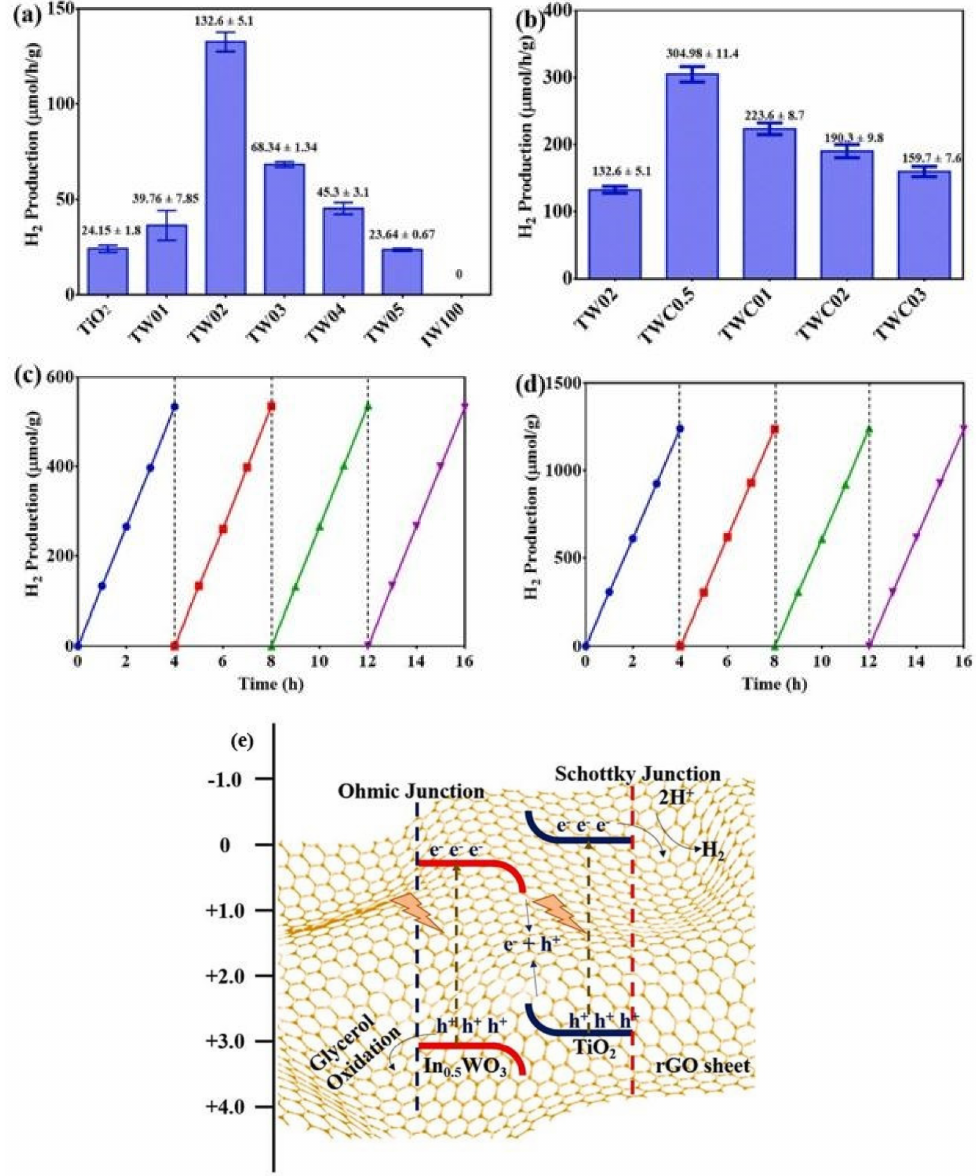
Figure 12. Photocatalytic H 2 production activity of ( a ) TiO 2 , In 0.5 WO 3 and different wt% In 0.5 WO 3 loaded photocatalysts, ( b ) Different wt% rGO loaded TiO 2 /2 wt% In 0.5 WO 3 photocatalysts, ( c ) Stability test for optimized TiO 2 /2 wt% In 0.5 WO 3 , ( d ) Stability test for rGO optimized